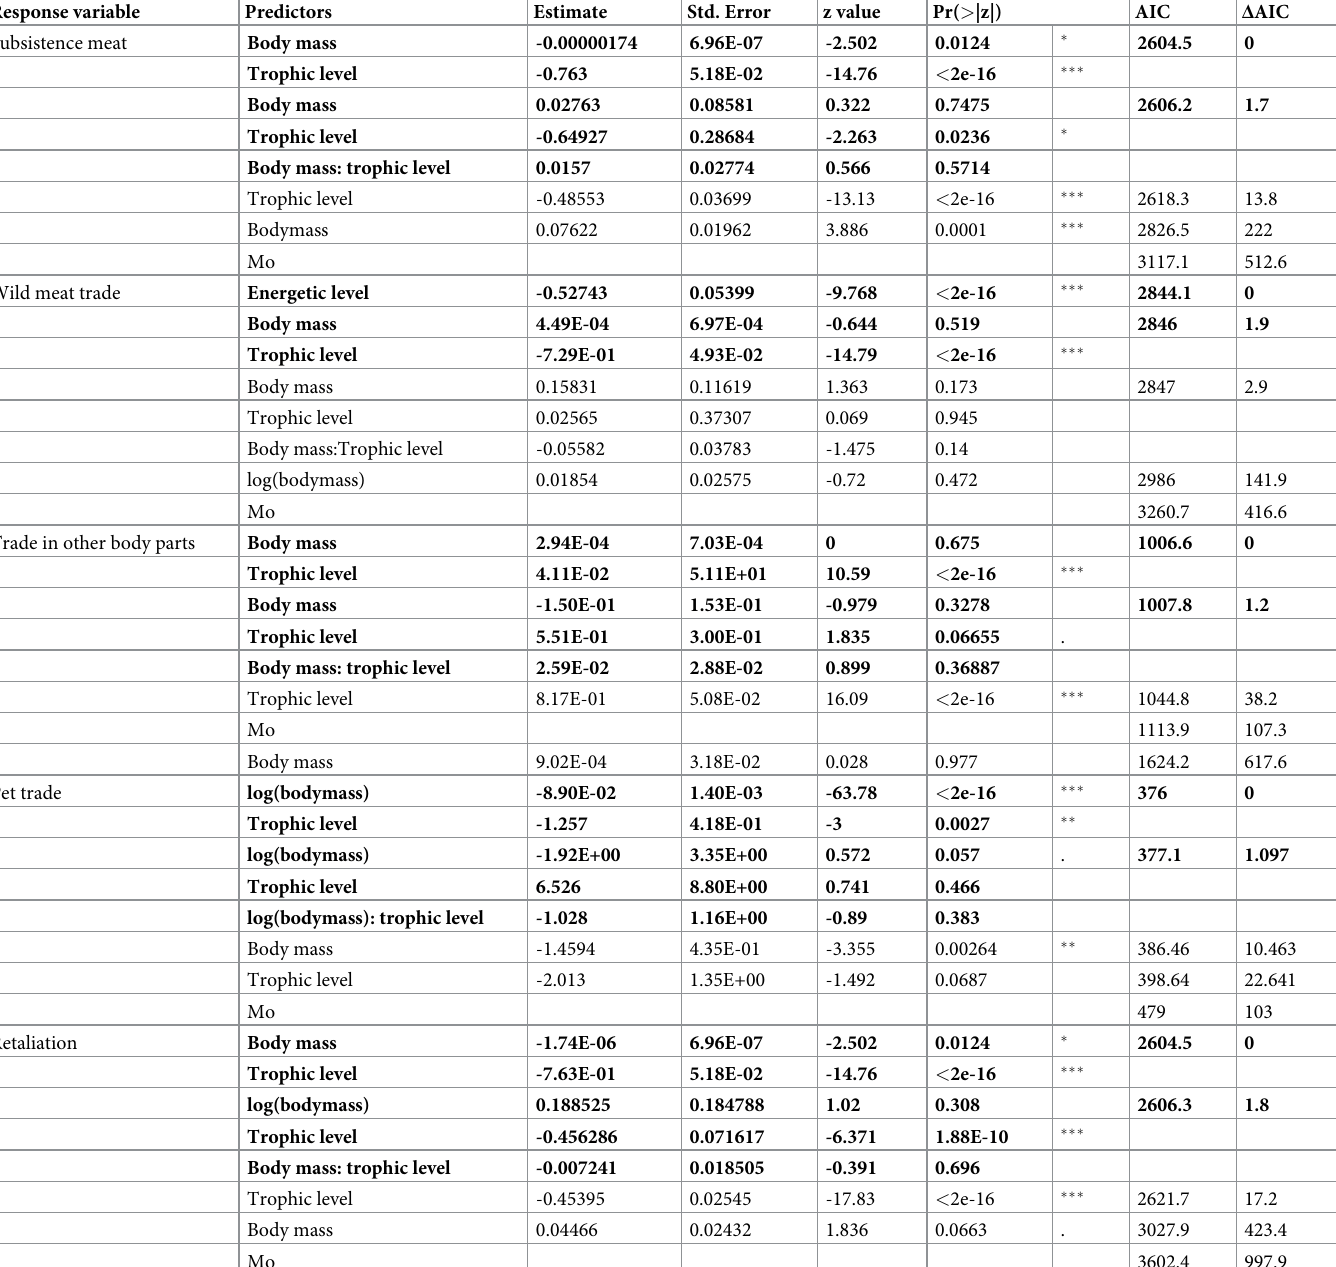
Table 1. Model selection and details of the models using generalized linear mixed models (GLMMs) to examine the effects of body size and dietary level on the num- ber of hunters reporting each form of hunting motivation for killing any given